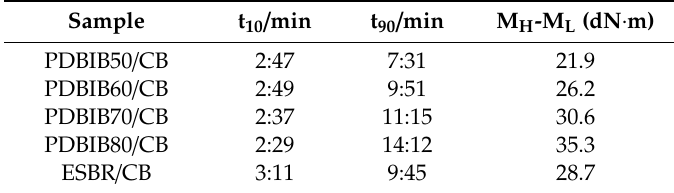
Table 6. Curing for the PDBIB/CB and ESBR/CB compound rubber.